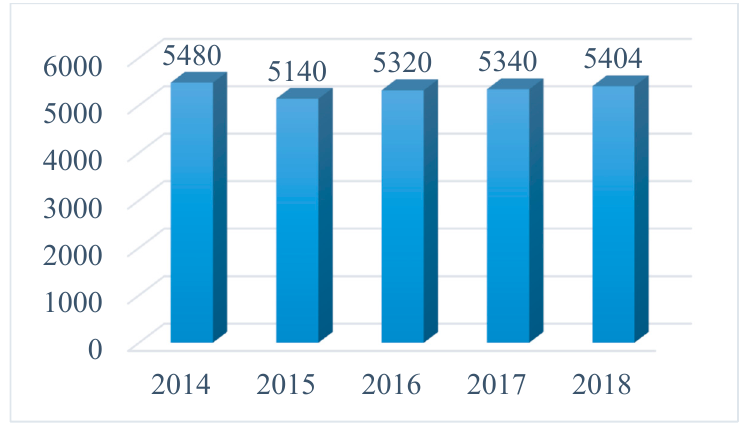
Figure 2. Value of agricultural production in the Czech Republic (in EUR millions) [27].